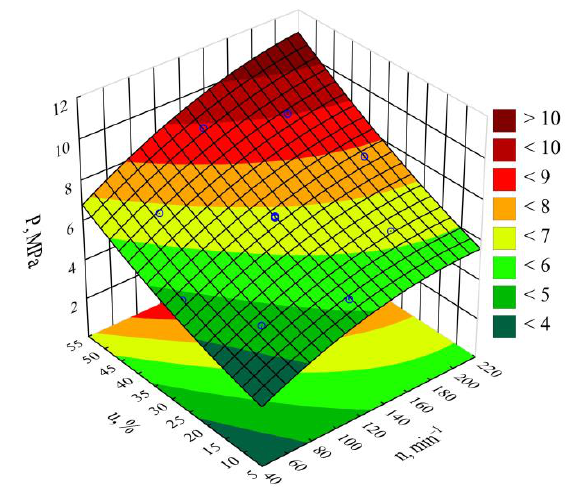
Figure 7. Response surface graph for the polymer blend pressure P versus the screw rotational speed n and bran mass fraction u.